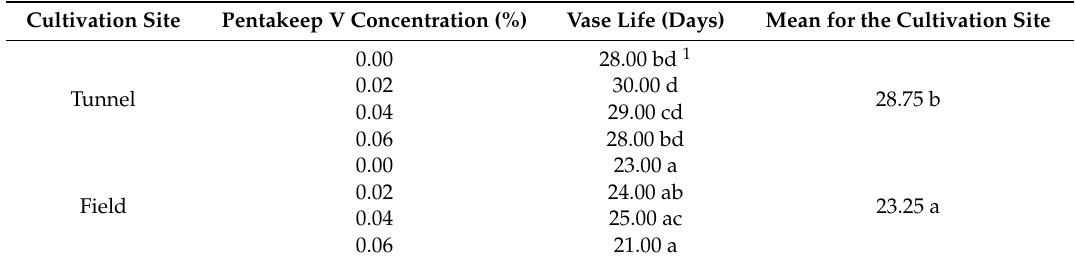
Table 1. E ff ect of growth conditions (unheated foil tunnel and open field) and foliar treatment (six times during vegetative period) with di ff erent concentrations of Pentakeep V (0.00%, 0.02%, 0.04%, 0.06%) on the vase life of P. multiflorum cut foliage.